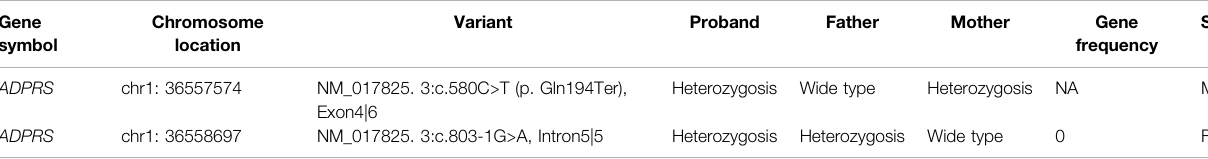
TABLE 1 | The results of whole exon sequence of c.580C > T and c.803-1G > A.